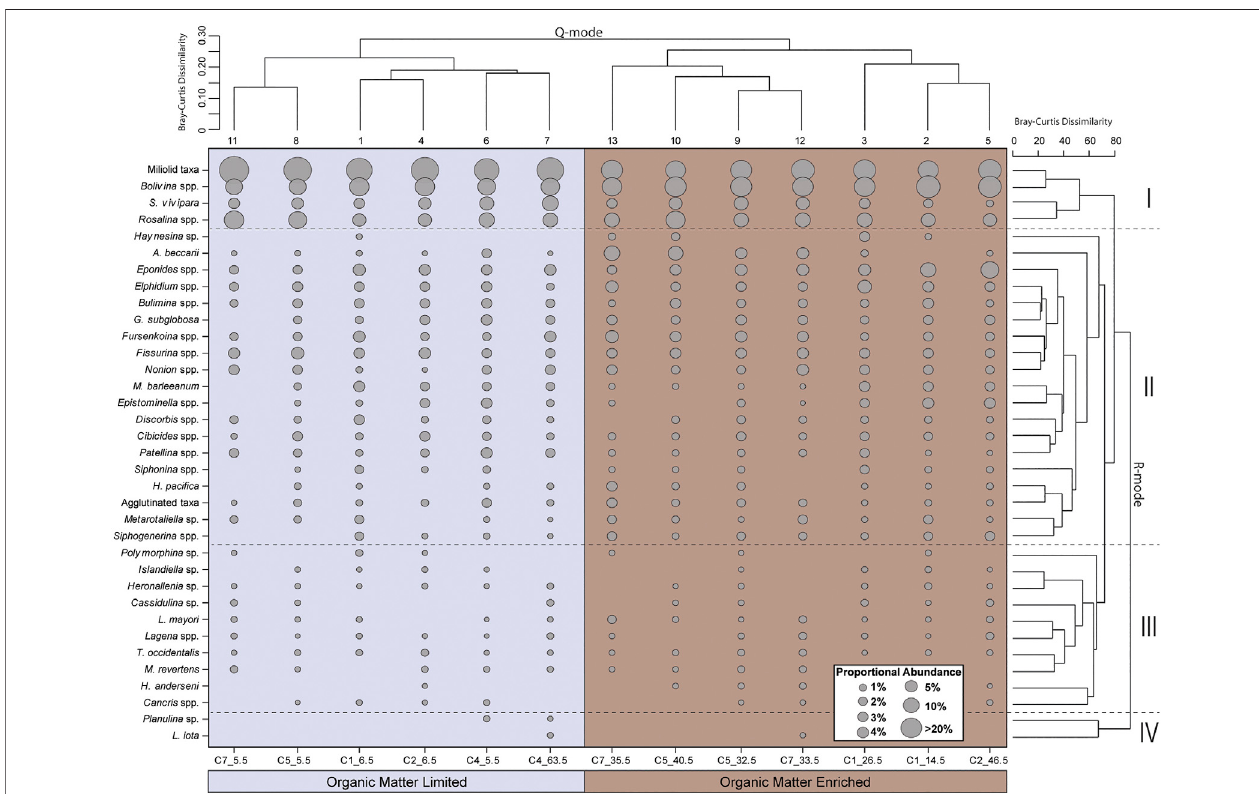
FIGURE 6 | Dendrogram produced from two-way hierarchical cluster analysis of the benthic foraminiferal data in Aerolito. The Q-mode cluster analysis identi fi es two main groups: OM-limited Community (purple fi eld) and OM-enriched Community (brown). The R-mode cluster analysis highlights dominant (Group I), common (GroupII),rare(GroupIV),andveryraretaxa(GroupIV).Samplecodes(bottomrow)arebasedonthecoreIDfollowedbysampledepthincm(e.g.,C7_5.5wassampled from Core 7 at 5.5 cm core